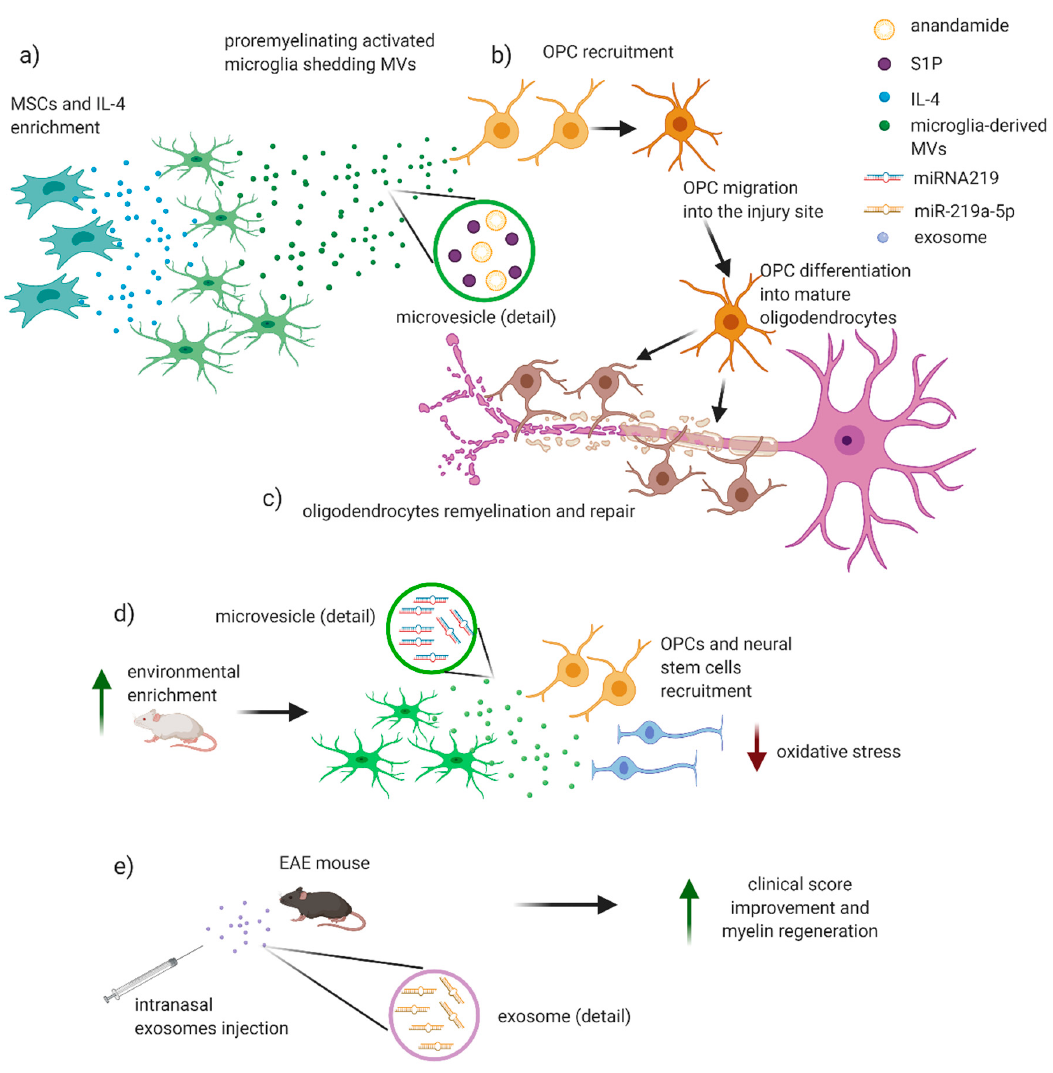
Figure 3. Potential role of EVs in remyelinating processes in MS / EAE. EVs may have a potential role in remyelination and reparative processes in MS / EAE. ( a ) Incubation of microglial cells with IL-4 and MSCs allows the developing of a pro-regenerative microglial phenotype that secretes MVs containing anandamide and sphingosine 1 phosphate (S1P). ( b ) These molecules are strong chemoattractants for oligodendroglial precursor cells (OPCs) that migrate near the injury site and di ff erentiate into mature oligodendrocytes, ( c ) wrapping on damaged axons and thus restoring the integrity of